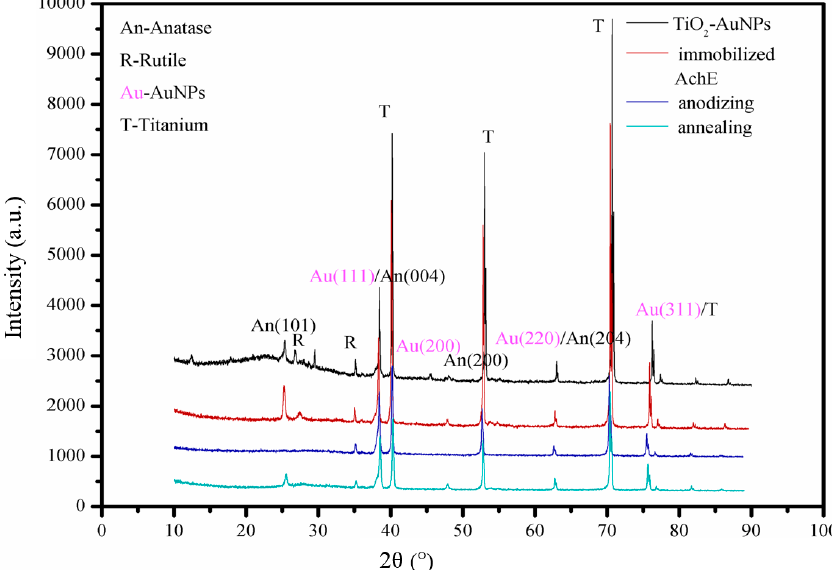
Figure 1. X-ray Diffraction (XRD) patterns of samples including anodized TiO 2 nanotube arrays (TiO 2 NTs), TiO 2 NTs annealed under 500 °C, deposited AuNPs and immobilized with AchE.